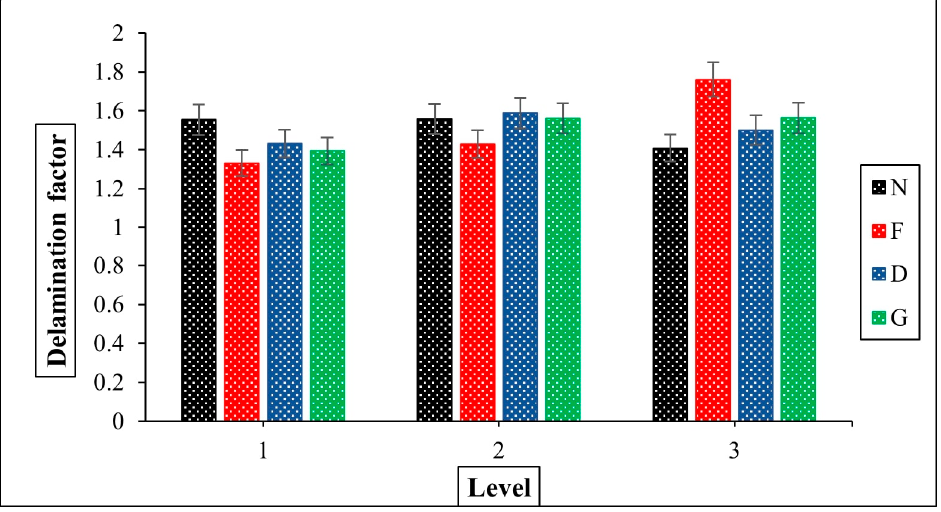
Figure 9. Delamination factor vs. milling factors analysis.